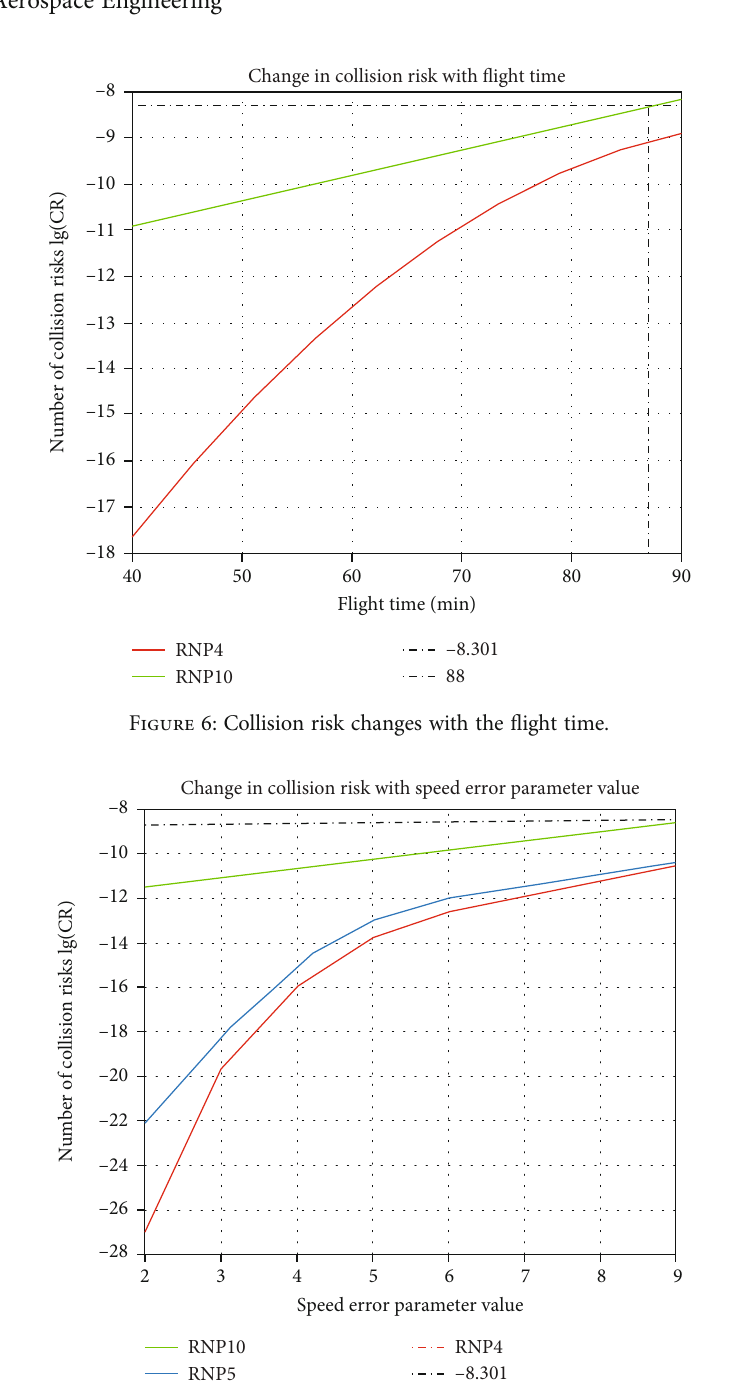
Figure 7: Collision risk changes with navigation speed